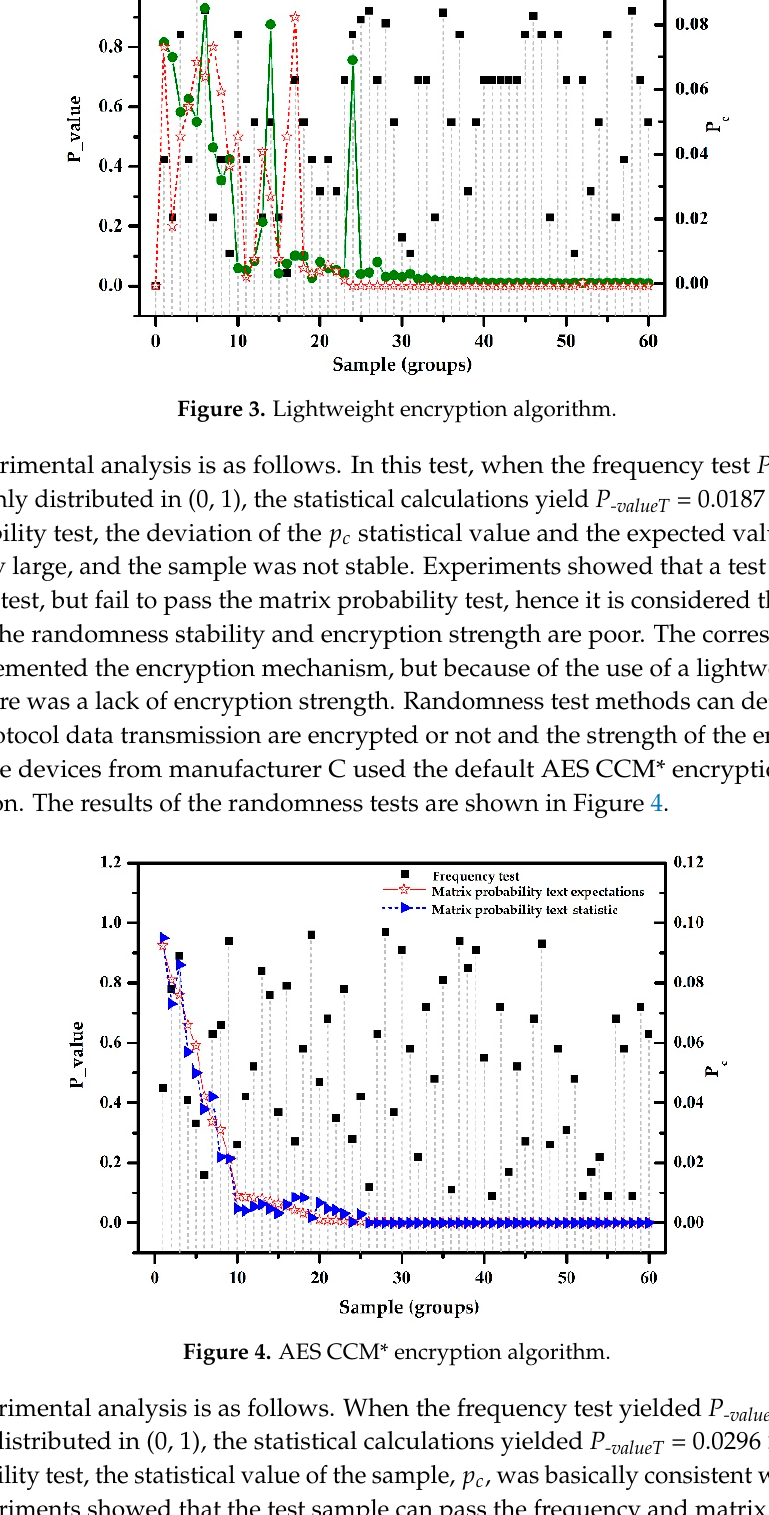
Figure 4. AES CCM* encryption algorithm.